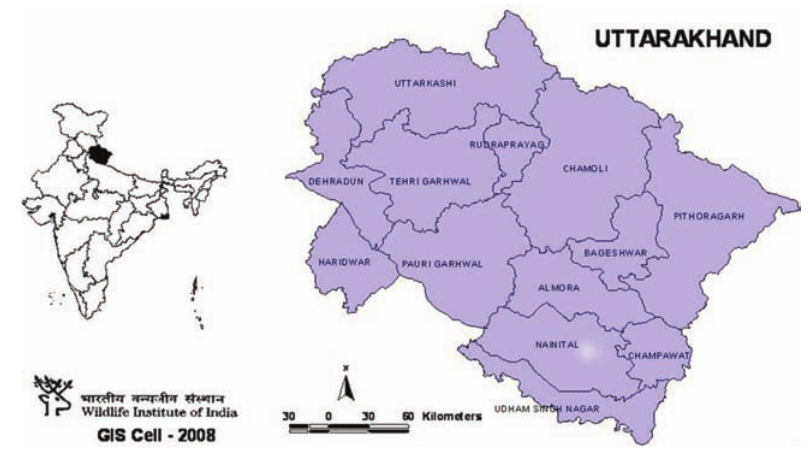
Figure 1. Map of the study area.